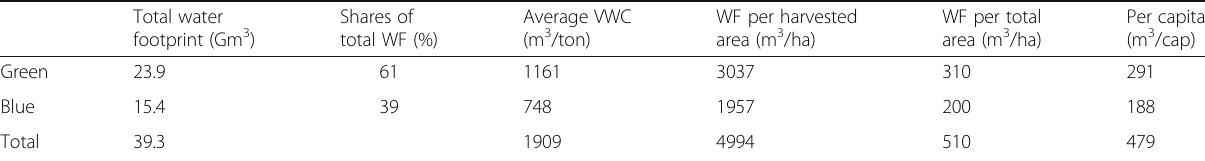
Table 1 Wheat ’ s annual average water footprint statistics for Turkey (2008 – 2019)